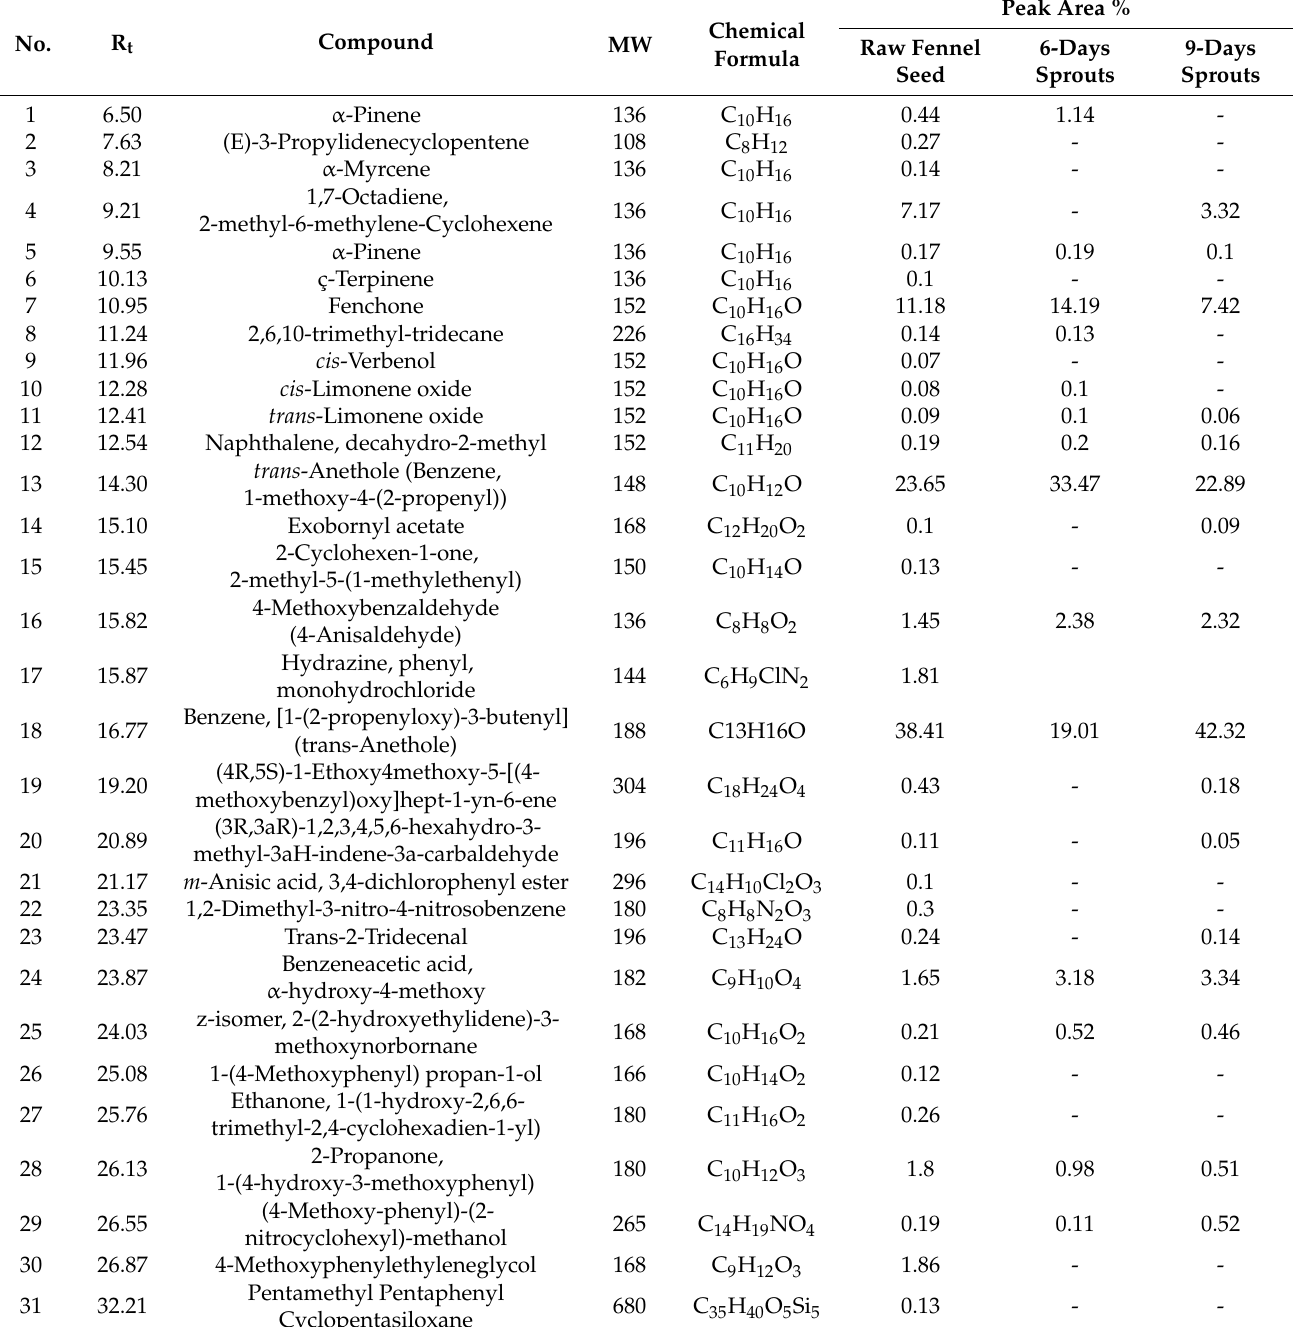
Table 2. GC-MS identification and quantification of volatile compounds in F. vulgare seeds and